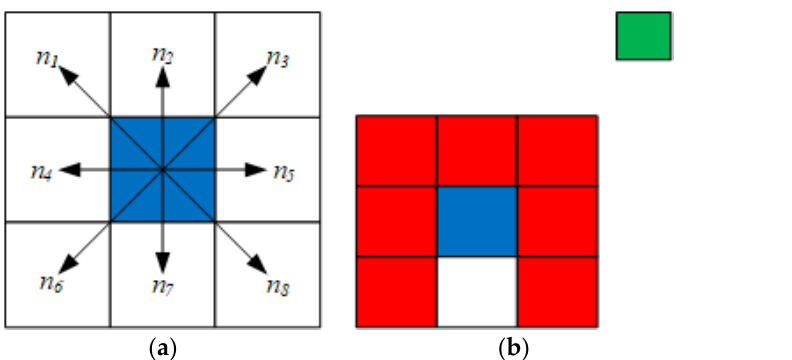
Figure 5. ( a ) 8 directions of the search grid; ( b ) Diagram of obstacles does not completely surround current point.